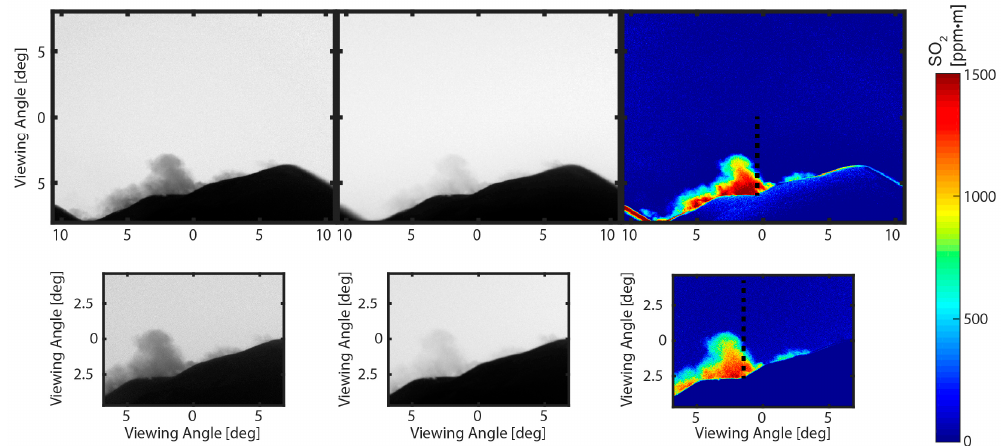
Figure 2. Images of Mount Etna’s plume taken with the PiCam units (top panels; pixels binned to 648 × 486) and the JAI systems (bottom panels) at 08:22:16 UTC on 19 July 2016. From left to right, the panels display 310 nm images, 330 nm images, and calibrated SO 2 column amounts. The dotted black line in the calibrated SO 2 images displays the profile across which integrated column amounts were retrieved.